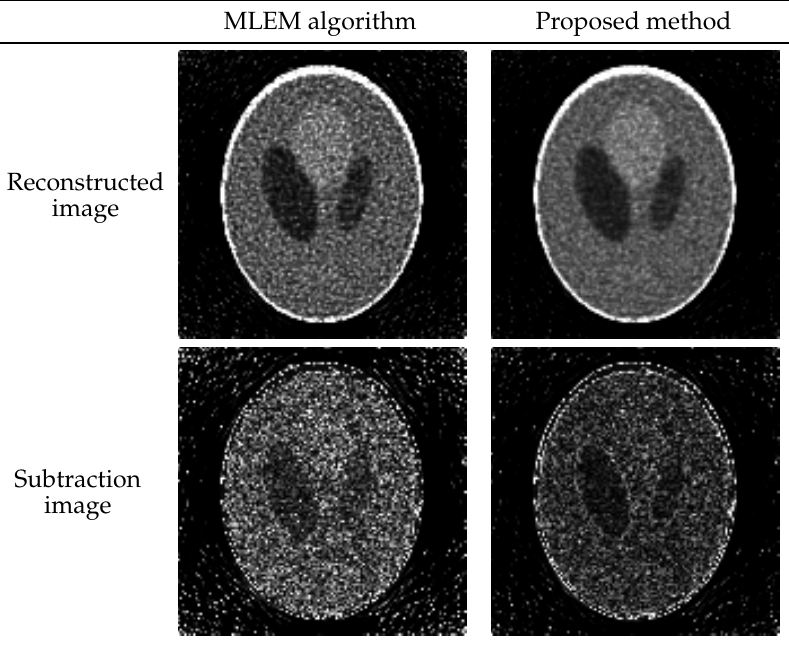
Figure 15. Images reconstructed from projection y 6 by using proposed method with parameter ˆ λ 1 and the MLEM algorithm. Subtraction images display in the range from 0 to 0.3.